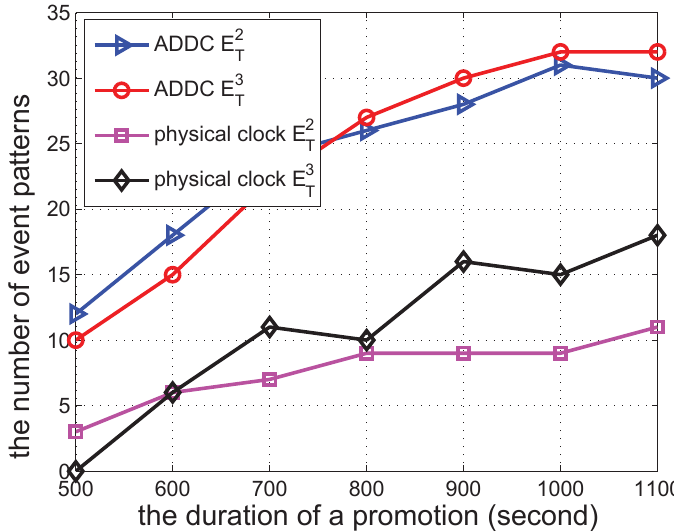
Figure 7. The number of event patterns vs. the duration of a promotion.